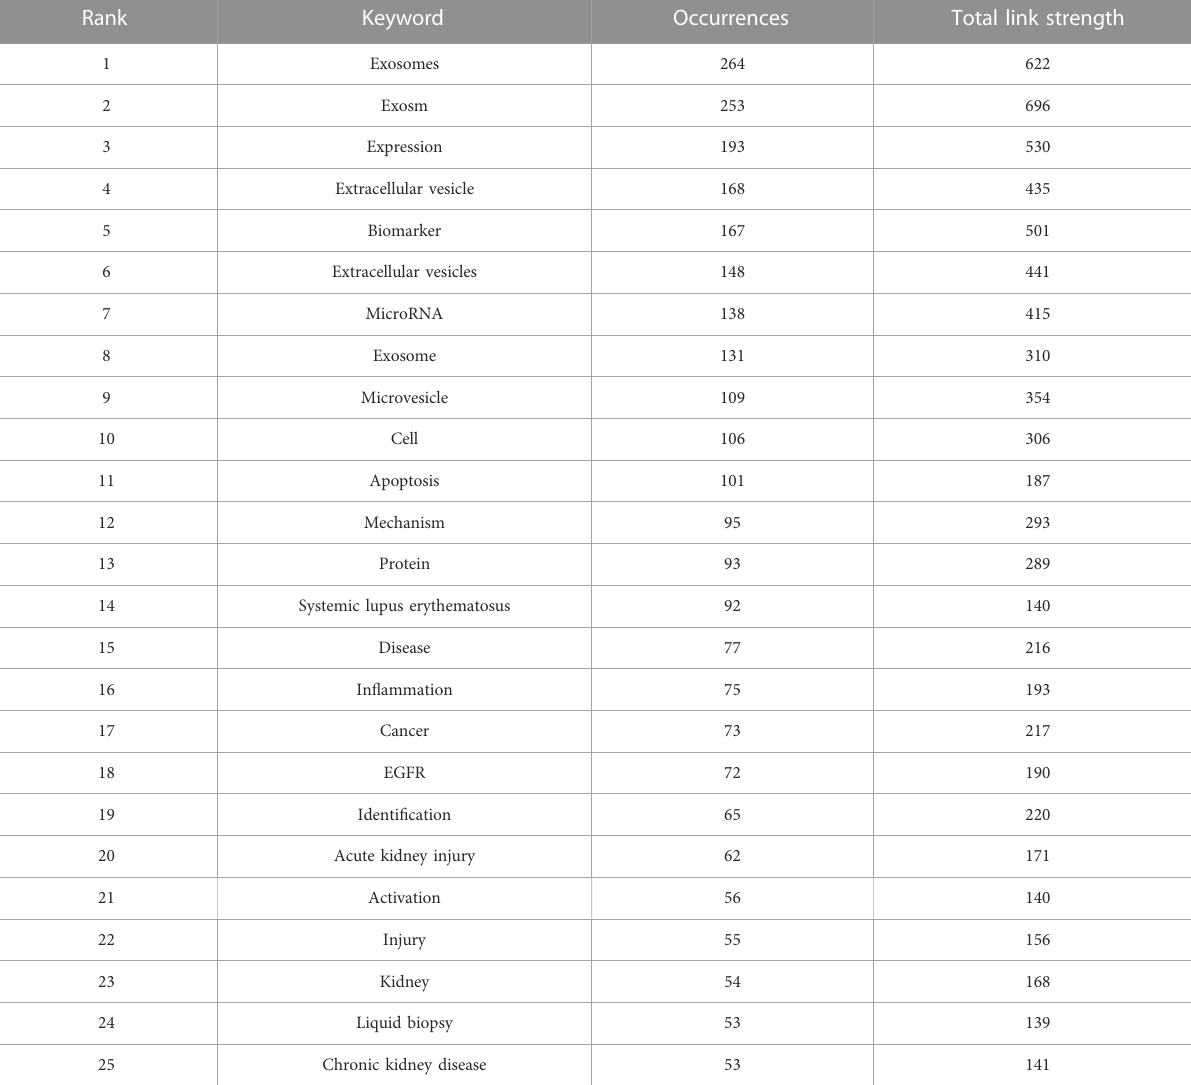
TABLE 6 Top 25 co-occurrence keywords related to EVs in kidney disease.